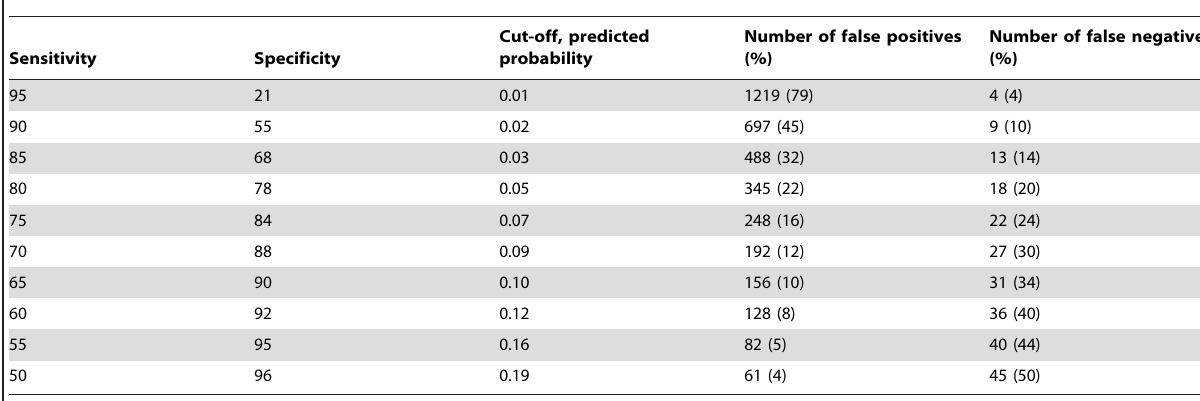
Table 3. Discrimination measures at selected sensitivity cut-offs*.